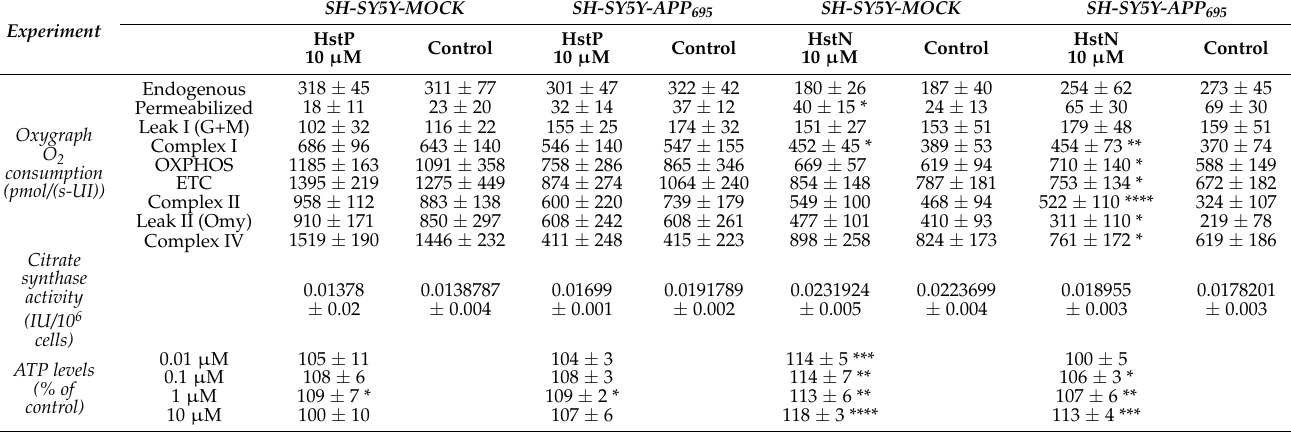
Table 2. Respiration, citrate synthase activity, and ATP levels of SH-SY5Y cells after incubation with HstP and HstN. For respiration, cells are incubated for 24 h with 10 µ M HstP and HstN or EtOH and PC as control, N = 10 for HstP and N = 12 for HstN. Respective mean values are shown. * p < 0.05, ** p < 0.01, *** p < 0.001 and **** p < 0.0001 compared to control. Significance was determined with Student’s unpaired t-test. Respiration of SH-SY5Y-MOCK and -APP 695 cells was adjusted to international units (IU) of citrate synthase activity. ATP levels are given in % of control and were measured after 24 h of incubation with 0.01–10 µ M HstP. Cells treated with DMEM served as a control. HstP, hesperetin in pure form; HstN, hesperetin